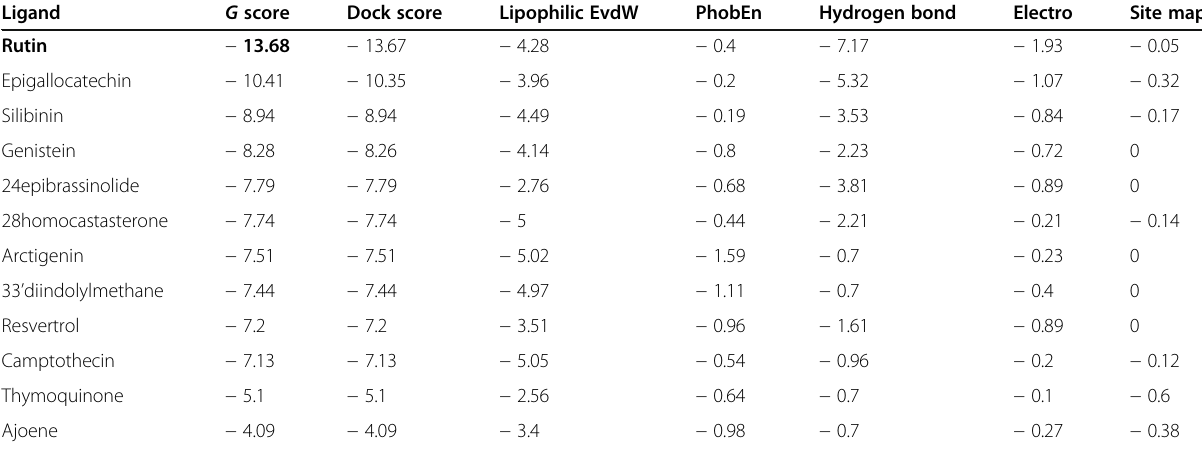
Table 5 Schrödinger maestro docking scores of ligands against